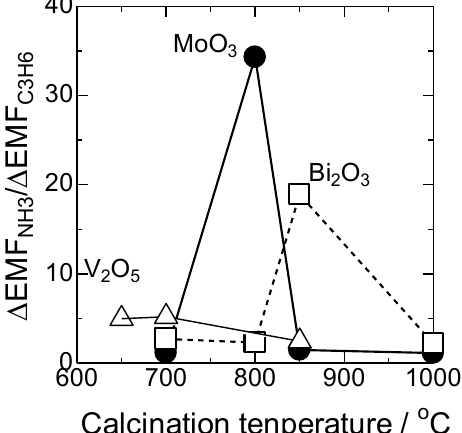
and C H at 600 °C on the sensor 3 3 6